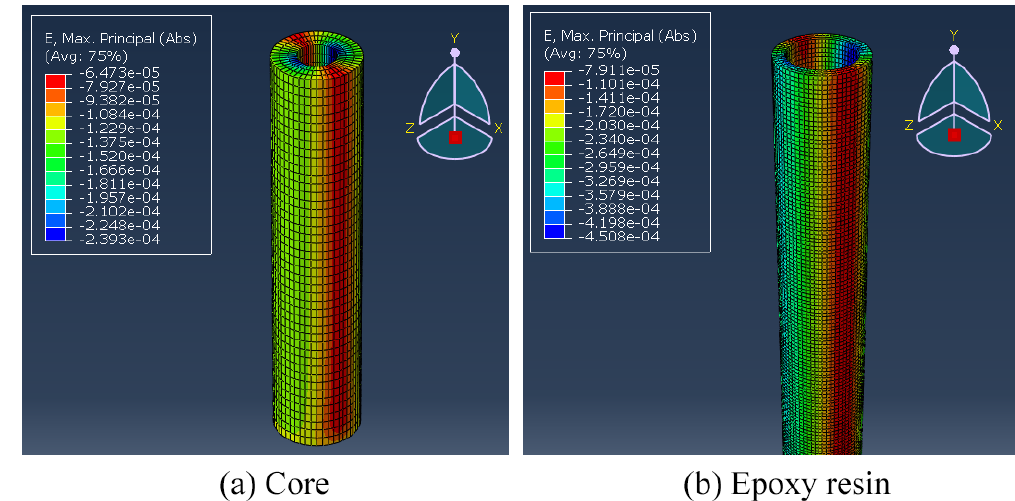
Figure 17. The absolute maximum principal-strain nephogram of the core and epoxy resin before overcoring.